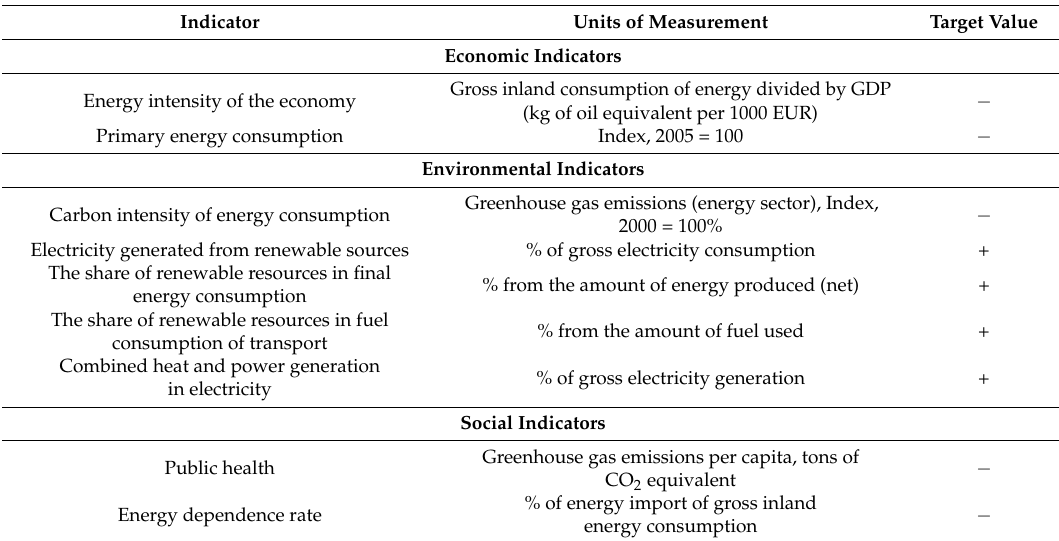
Table 7. Framework of sustainable energy development